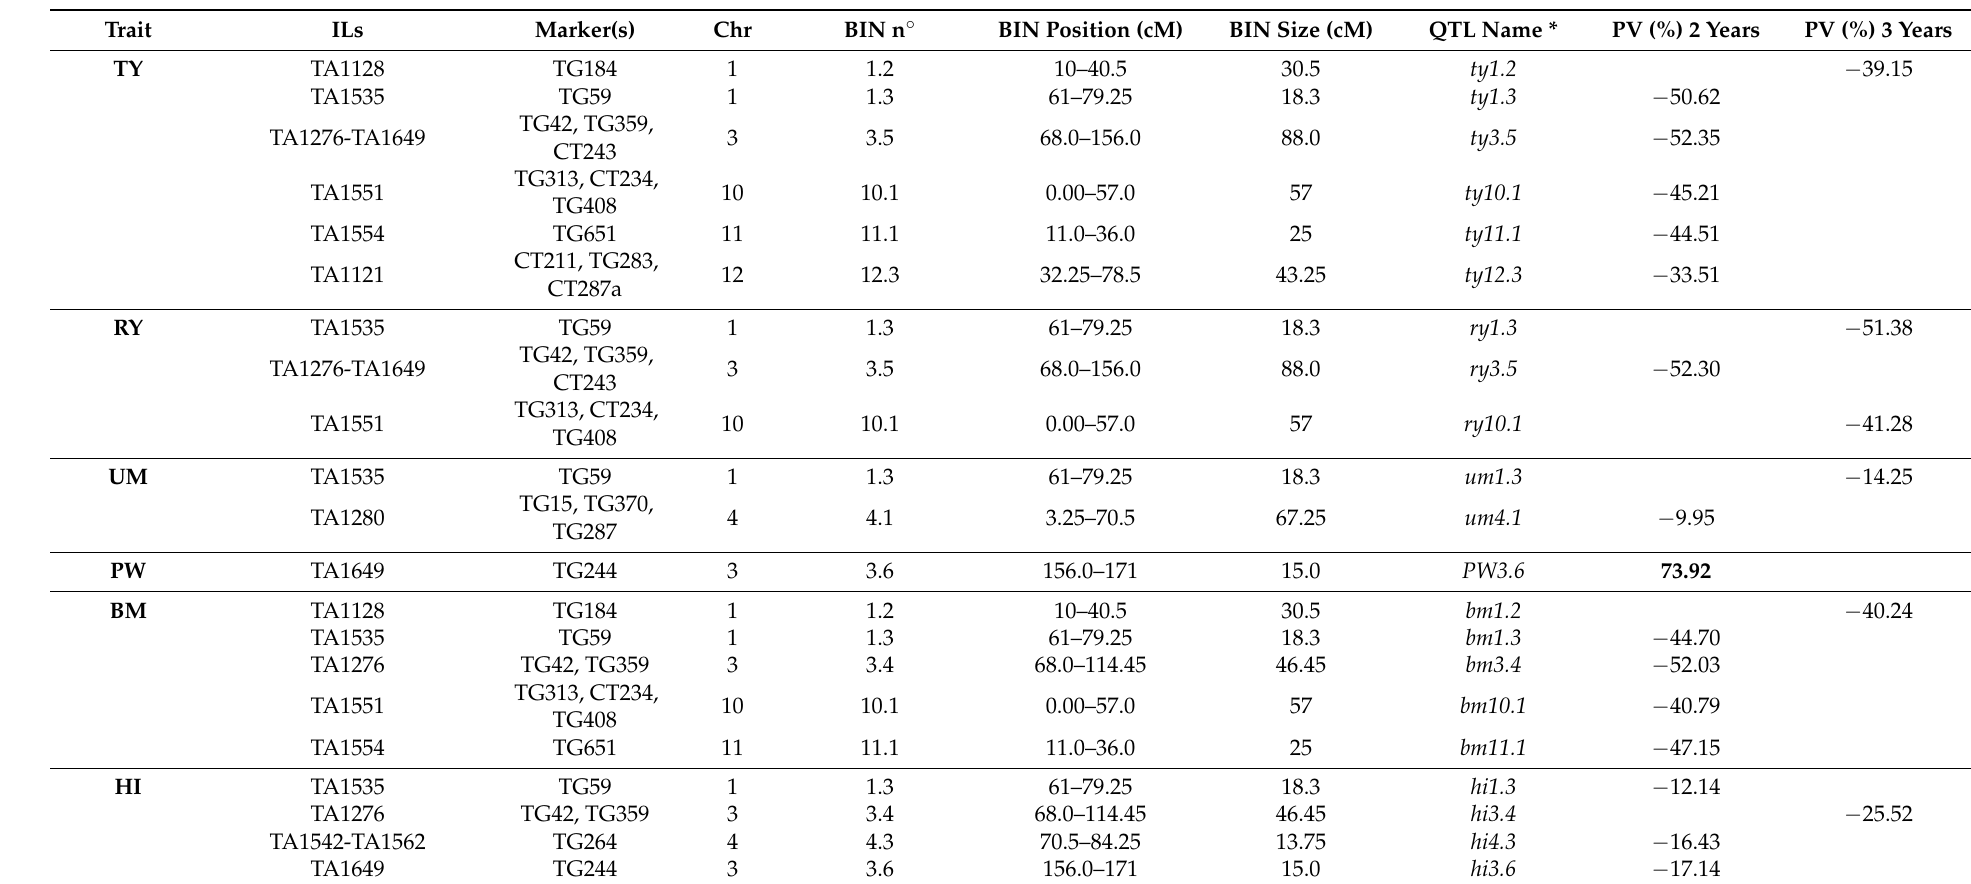
Table 5. List of putative chromosome regions underlying the variations of the traits (QTL) identified across two or three independent trials. PV = percent of the phenotypic variance estimated and - = not available. In bold are indicated the positive PV (%). In capital letters are indicated those QTLs that increased the performance of the traits compared to the control. BIN sizes are determined considering the overlapping regions plus the half-intervals between flanking markers and the nearest mapped loci (see Figure 4).